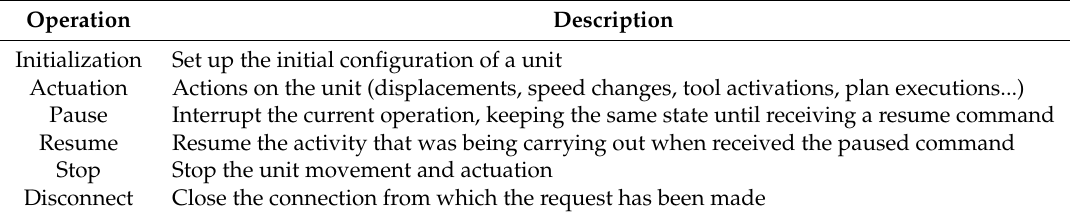
Table 2. Minimal set of operations considered for both aerial and ground